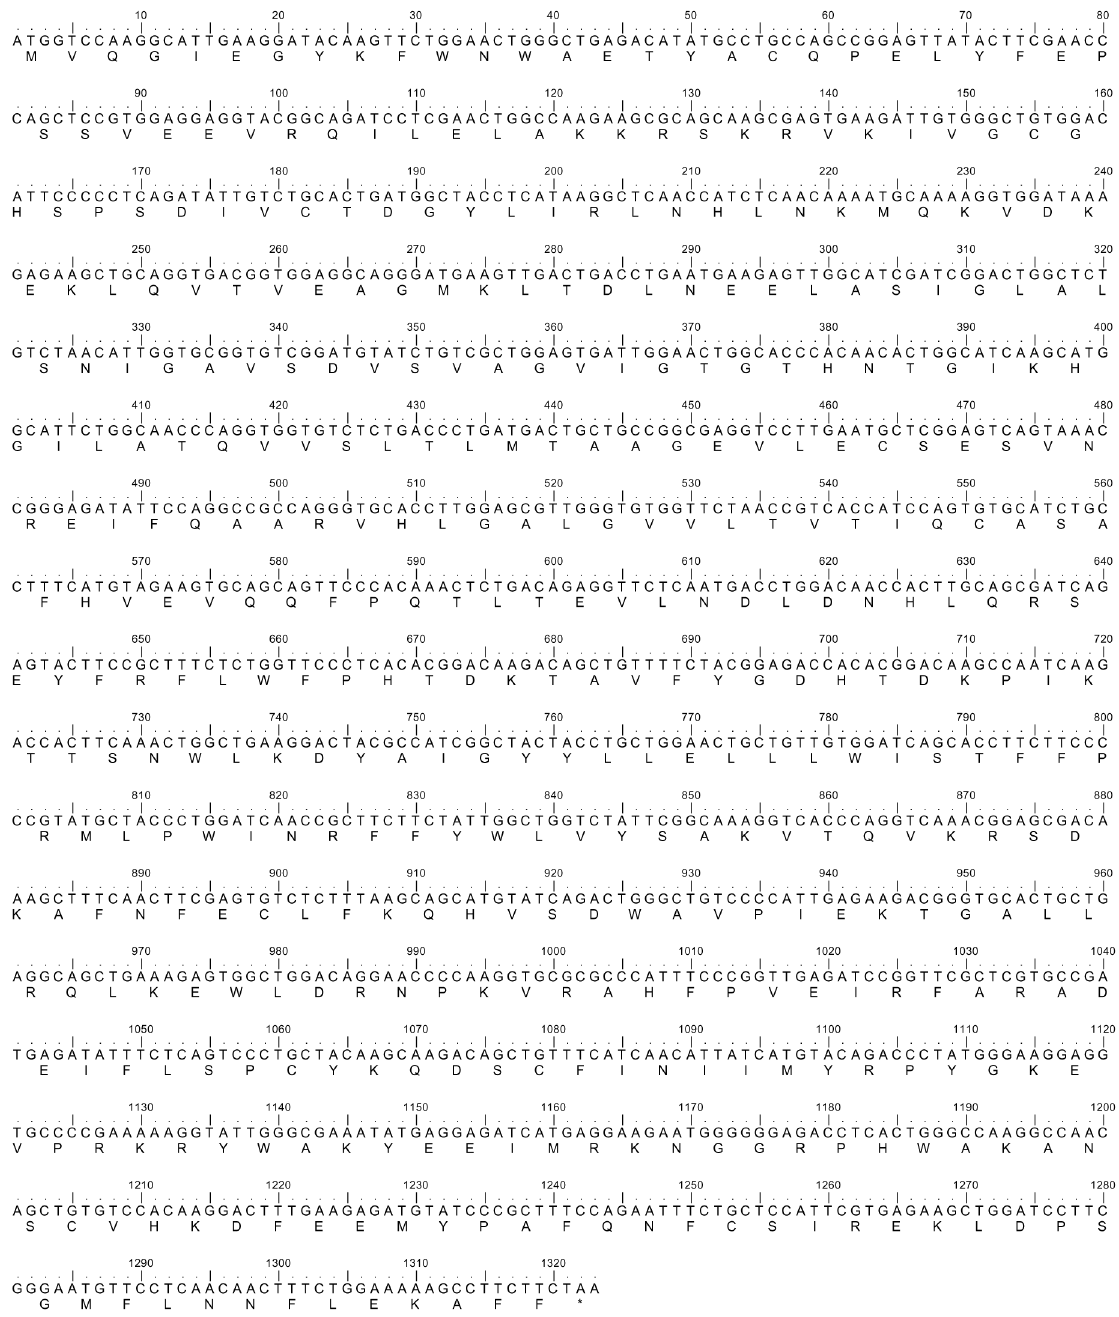
Figure 1. The cDNA sequence (GenBank accession number KC465465) of gulonolactoneoxidase ( gulo ) and the deduced amino acid sequence of gulonolactone oxidase (Gulo) from the kidney of Himanturasignifer .